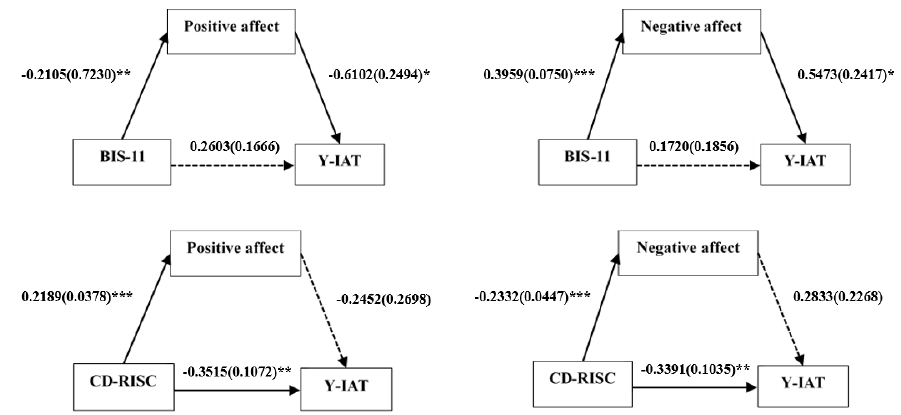
Figure 2. Mediation effects of affect status on the relationship between impulsivity or resilience and the severity of internet gaming disorder symptoms in the healthy control (HC) group. Unstandardized coefficients are presented with standard errors in parentheses. * p < 0.05, ** p < 0.01, *** p <